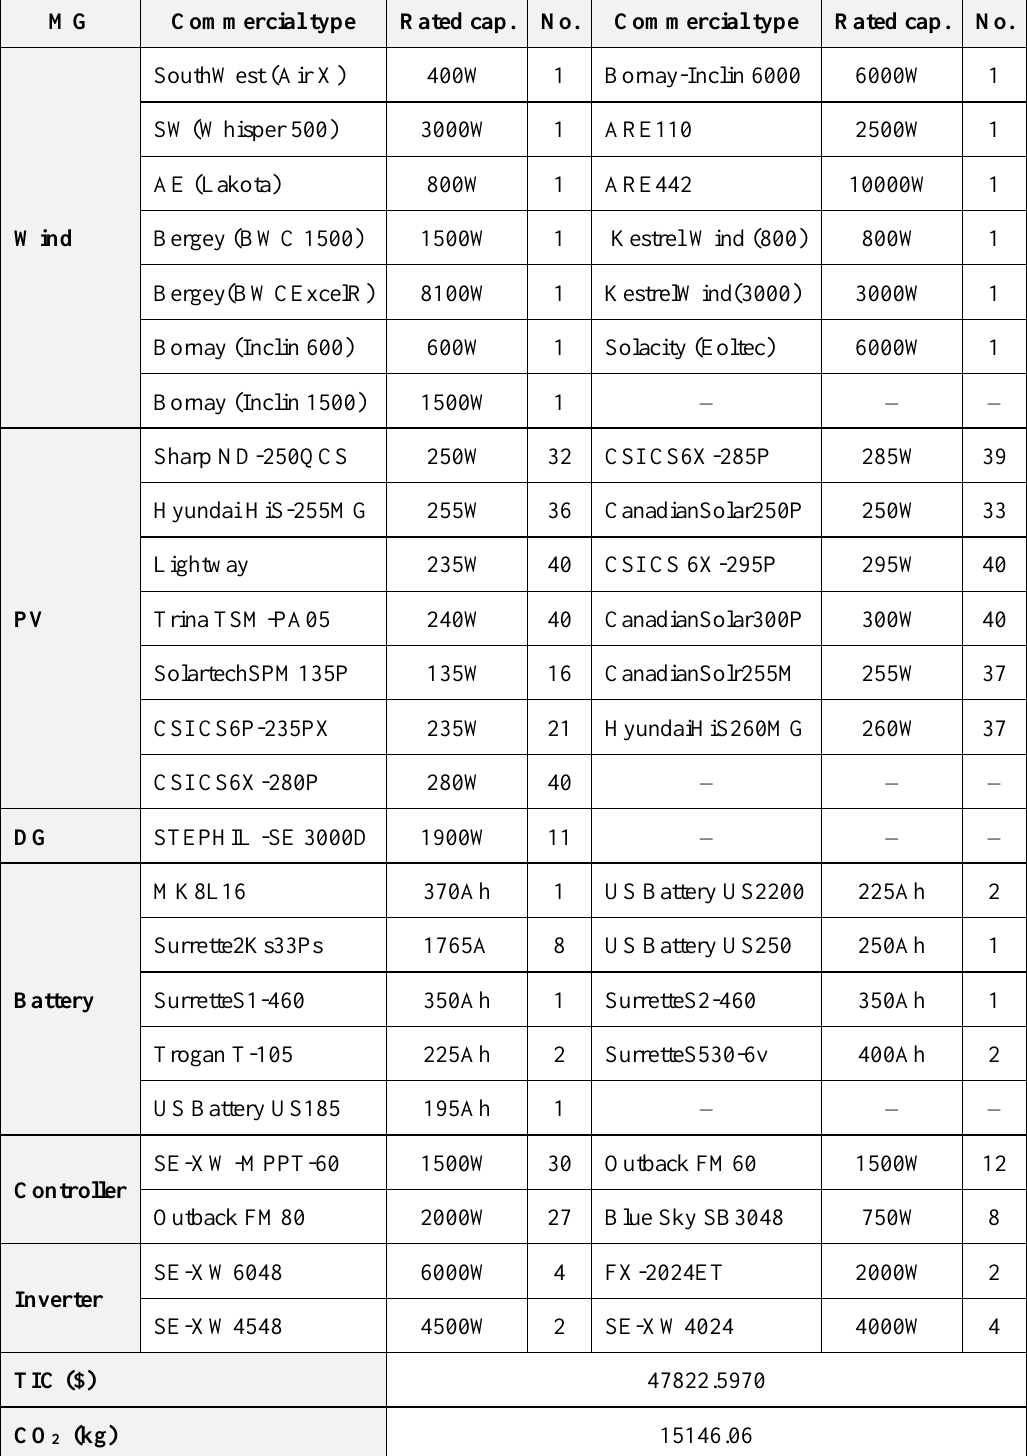
Table 8. MG sizing optimization results without emission